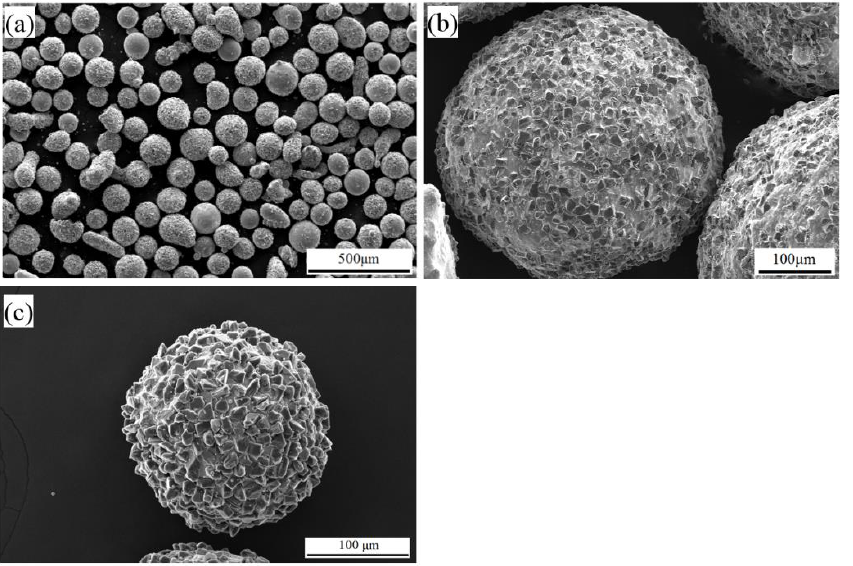
Figure 2. ( a ) SEM micrographs of the prepared MAP; ( b ) size with mesh no. 50; ( c ) and size with mesh no. 100.